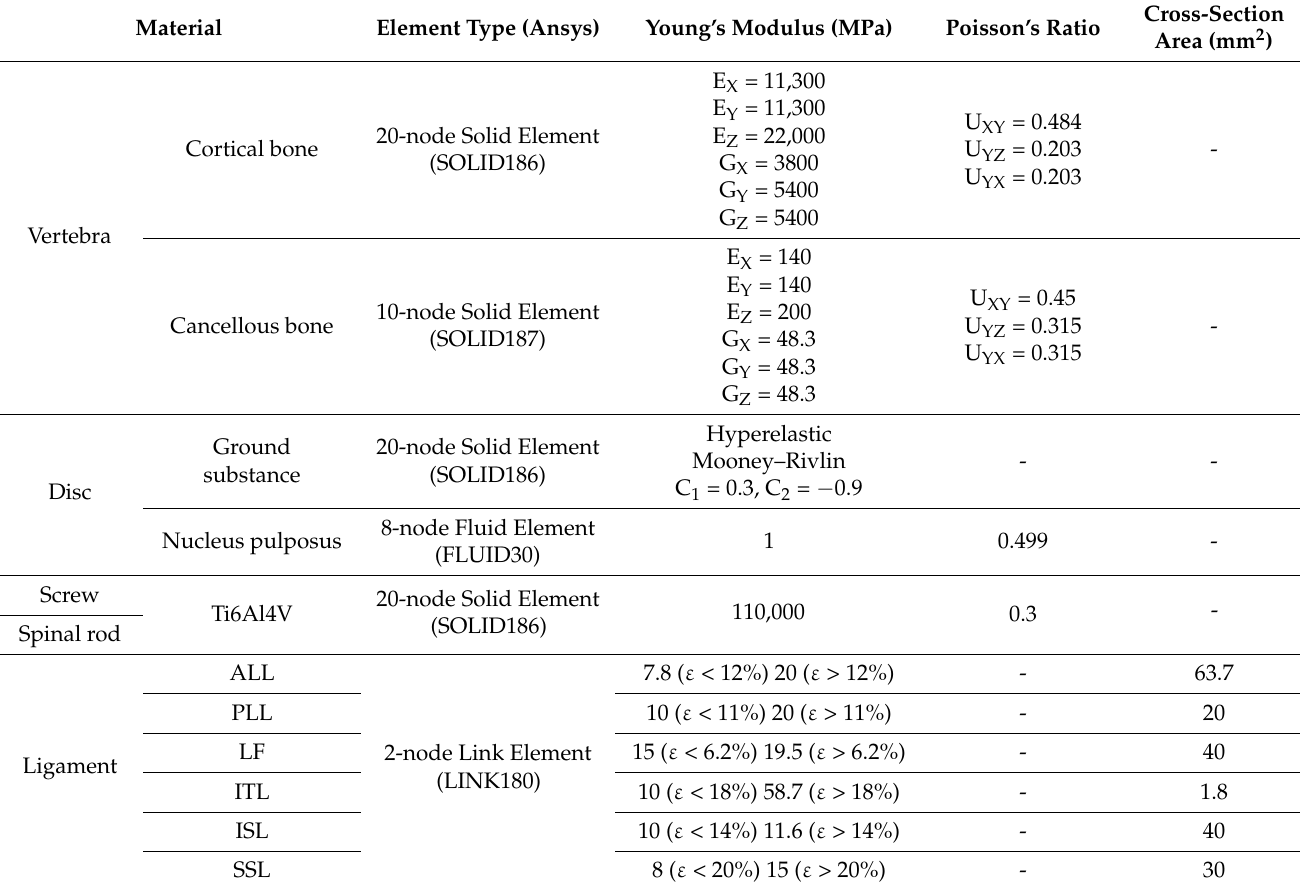
Table 1. Material properties of human spine used in